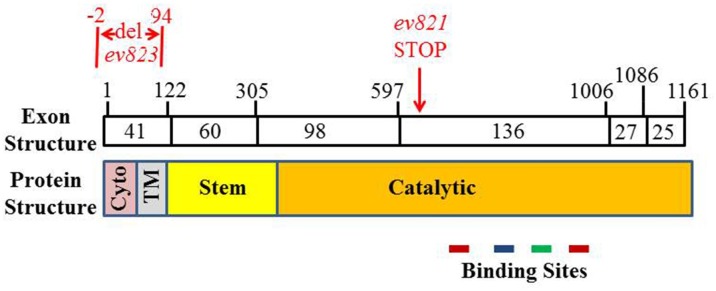
Organization of ngat-1 coding sequence and encoded protein.Boxes represent cDNA exons whose approximate codon size is indicated within. Exon boundaries and the positions of the ev821 point mutation (red) and the ev823 deletion (red) are indicated above the exon boxes. The corresponding protein domain structure [48] is indicated below the exons (Cyto = Cytoplasmic domain, TM = transmembrane domain). Color coding for binding sites is as in Fig 4.